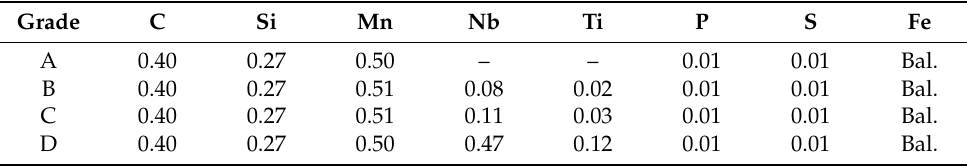
Table 1. Chemical compositions of the test steels (wt. %).